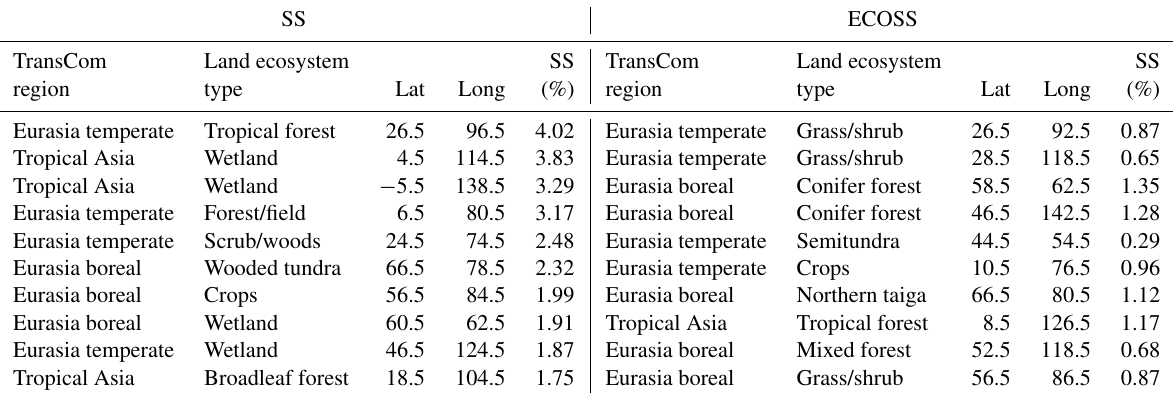
Eurasia temperate Wetland Tropical